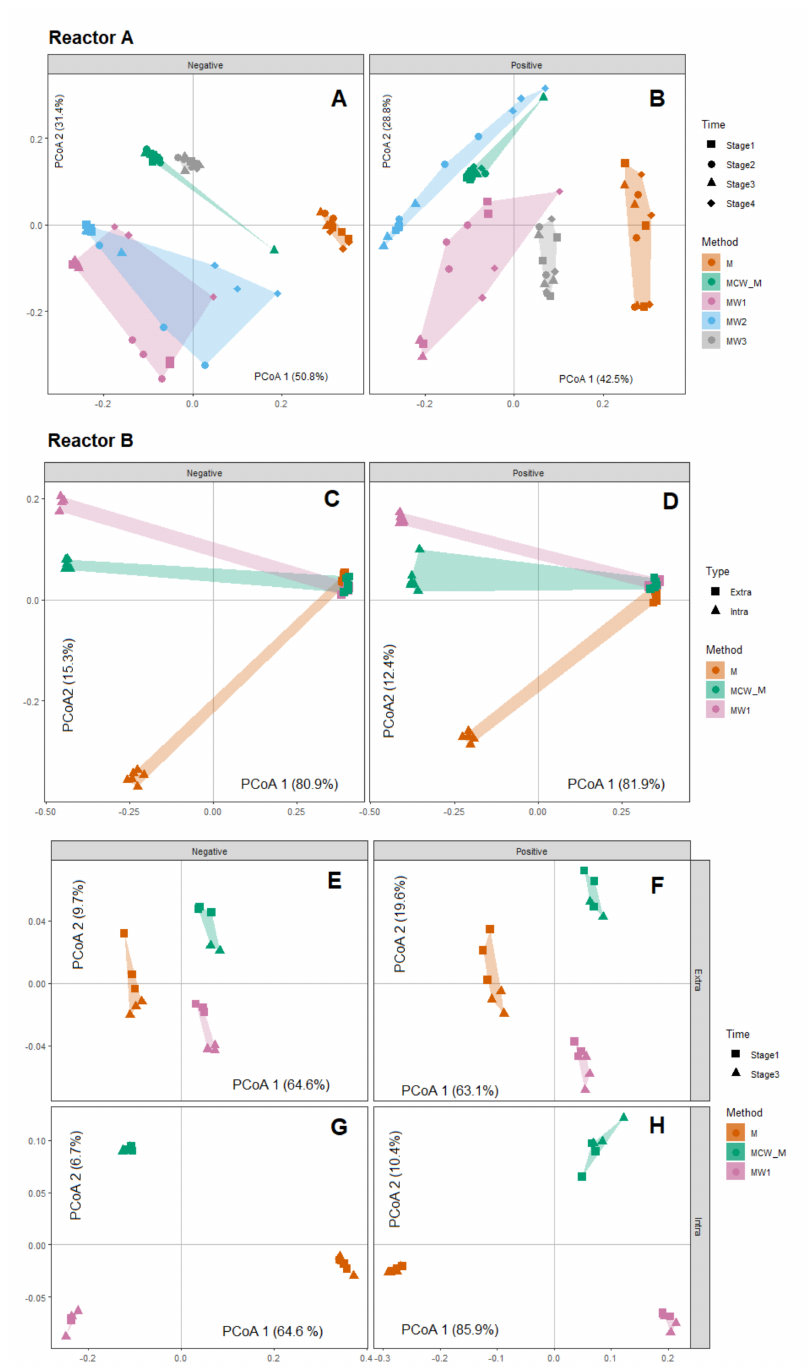
Figure 2. Principal coordinates analysis (PCoA) of untargeted metabolite profiles of Reactor A (panels A,B) and Reactor B (panels C–H) extracted by different extraction solvents. ( A ) PCoA analysis of negative mode data, with samples from each of the five solvent methods delineated by coloured convex hulls and samples from each of the four time points by different symbols. ( B ) Positive mode data from Reactor A, with the same formatting as for panel A; ( C ) PCoA analysis of negative mode data from Reactor B, with samples from each of the three solvent methods delineated by coloured convex hulls and samples from each compartment (intra- or extra-cellular) delineated by symbol; ( D ) PCoA analysis of positive mode data from Reactor B, with the same formatting; ( E – H ) within—compartment PCoA analysis for extracellular negative ( E ) and positive ( F ) mode data, and intracellular negative ( G ) and positive ( H ) data; samples from each of the three solvent methods delineated by coloured convex hulls and samples from each experimental stage (time) delineated by